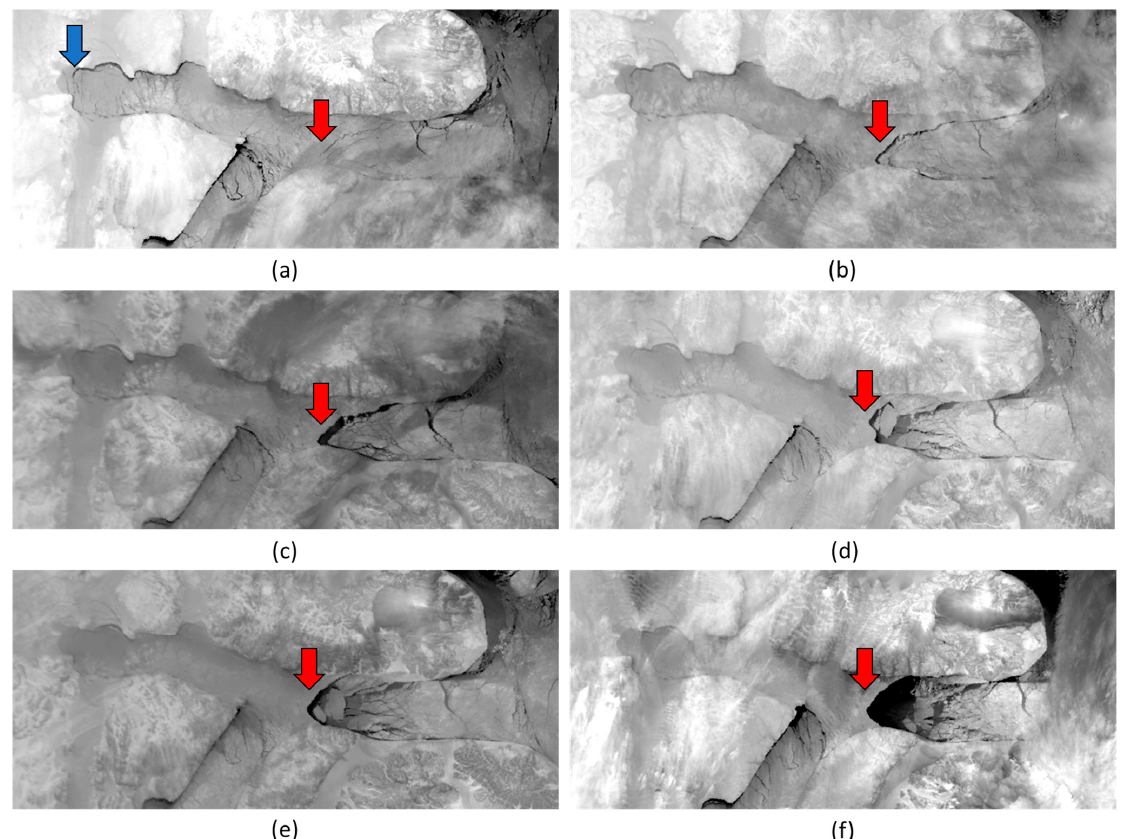
Figure 4. Sequence of satellite images showing the formation of the Lancaster Sound ice arch in 2019 for ( a ) 28 Jan, ( b ) 30 Jan, ( c ) 1 Feb, ( d ) 3 Feb, ( e ) 5 Feb and ( f ) 7 Feb. The ice arch appears established on 28 Jan (blue arrow), but a small break in the ice cover appears further east on the same day (red arrow). Over the next week, the new ice arch becomes established (red arrows), and remains con- stant until collapse on 18 Jun, while the ice to the west is frozen solid. This was a common sequence for the ice arch formation in Lancaster Sound. The movement of the ice is eastward from the arch.